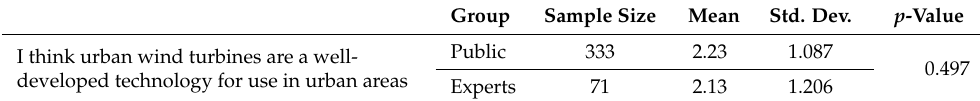
Table 2. Differences in perceptions on wind turbine technology between experts and public. Group Sample Size Mean Std. Dev. p -Value